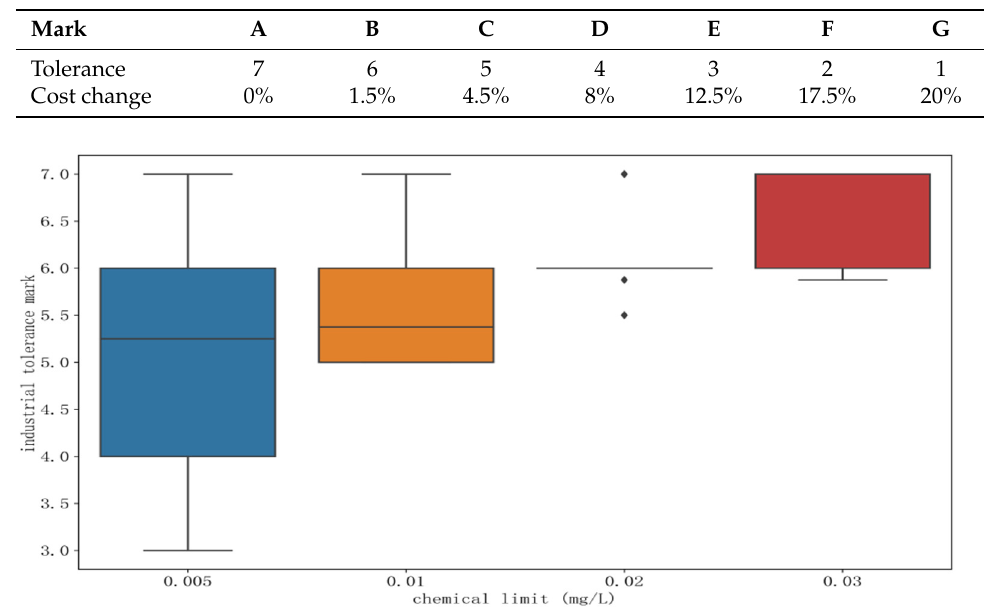
Figure 5. Acceptable consumer risk level. Table 3. Grading criteria based on tolerance and cost change.